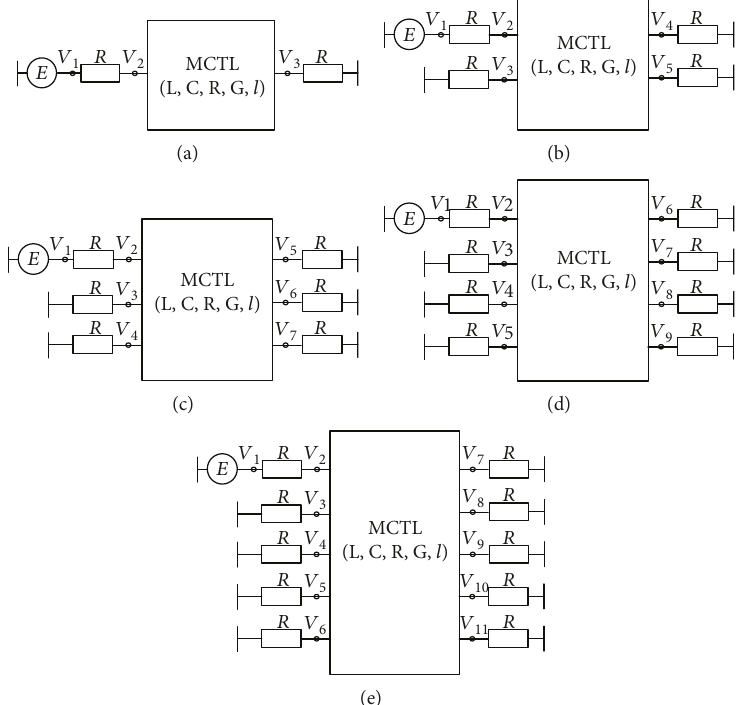
Figure 2: Schematic diagrams for one- (a), two- (b), three- (c), four- (d), and fi ve- (e) conductor structures. 01.32.63.95.2